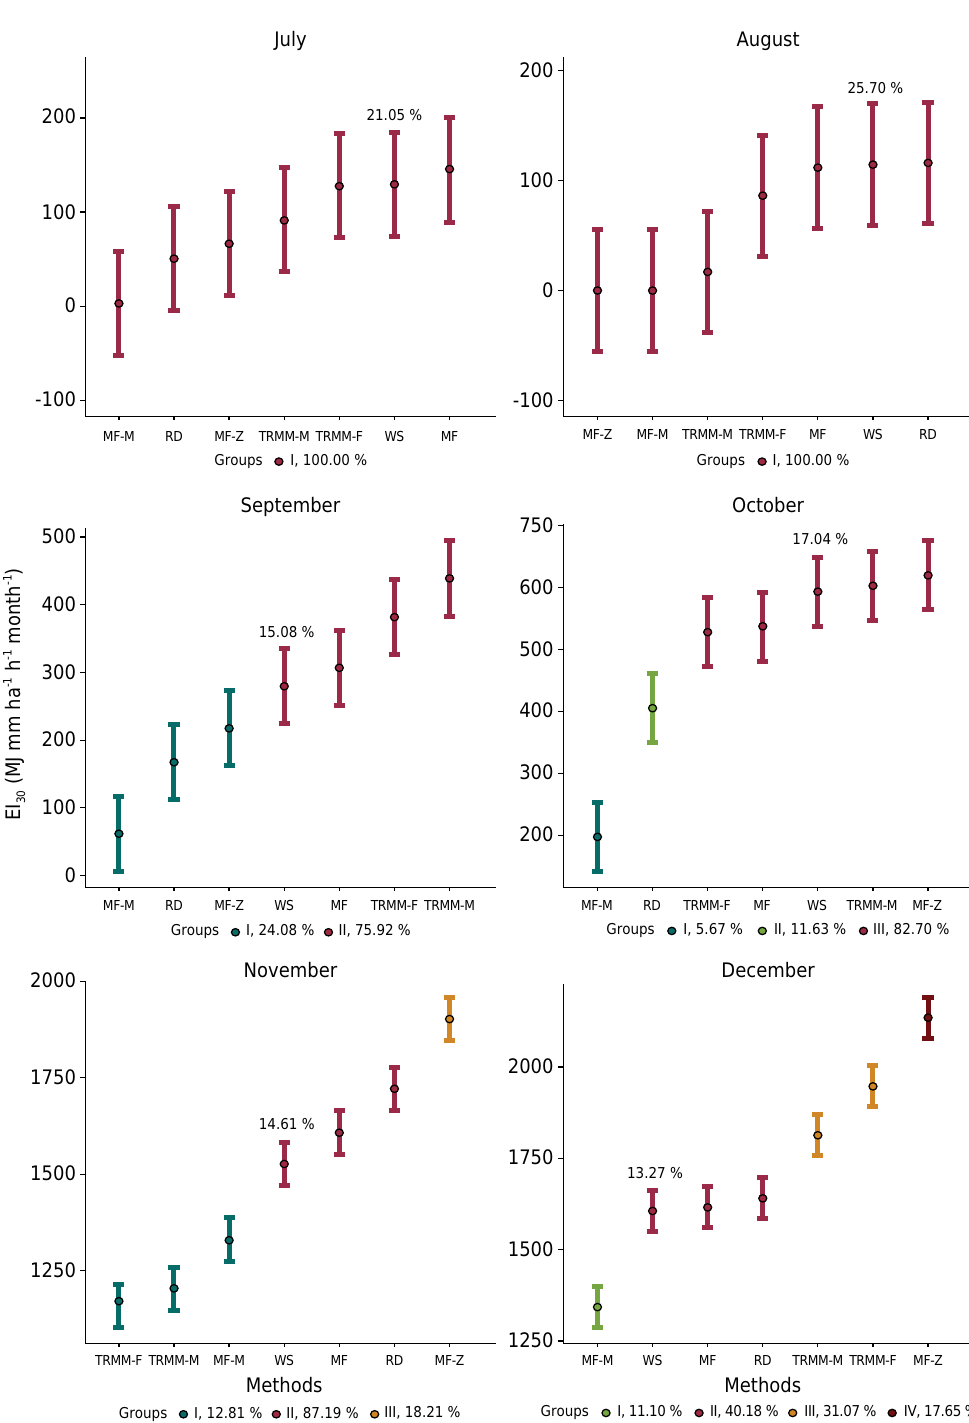
Figure 6. The univariate grouping of methods for estimation of the monthly rainfall erosivity indexes (July to December), by Scott and Knott (1974), with a Chi-squared significance level of 5 %. The blue color refers to the standard method (WS), the shades of green or red, were attributed to the methods that underestimate or overestimate the rainfall erosivity,